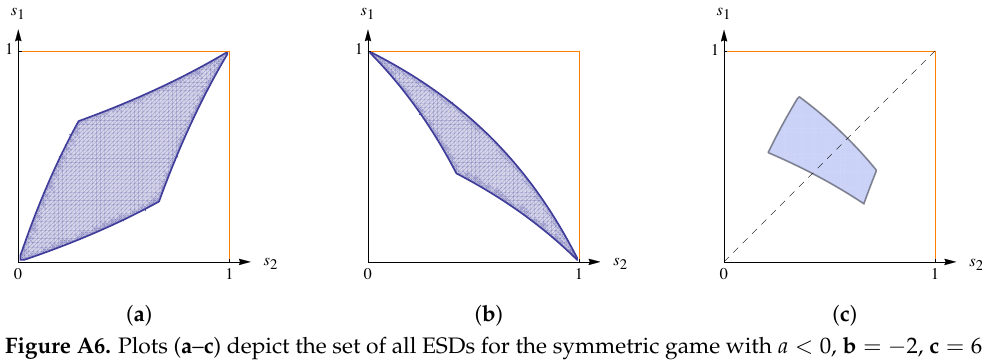
Figure A6. Plots ( a – c ) depict the set of all ESDs for the symmetric game with a < 0, b = − 2, c = 6, for the symmetric game with a > 0, b = 3, c = 4, and non-symmetric G ns , respectively.